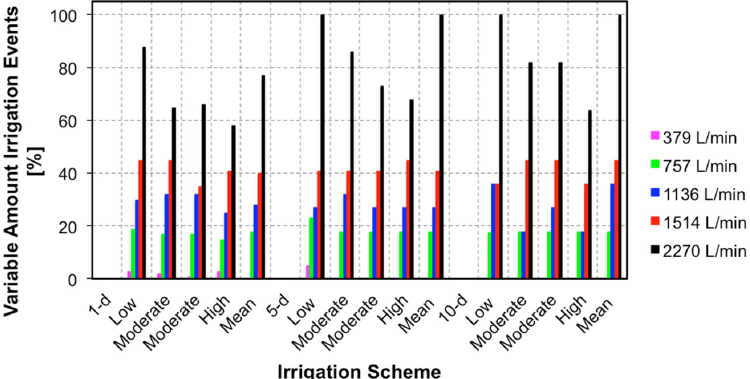
Figure 4. Variable-amount irrigation events (%) as a function of irrigation scheme for the 1-day, 5-day and 10-day irrigation frequency for Plainview, TX, USA. For each irrigation frequency, the variable-amount irrigation events are plotted as a function of well capacity.